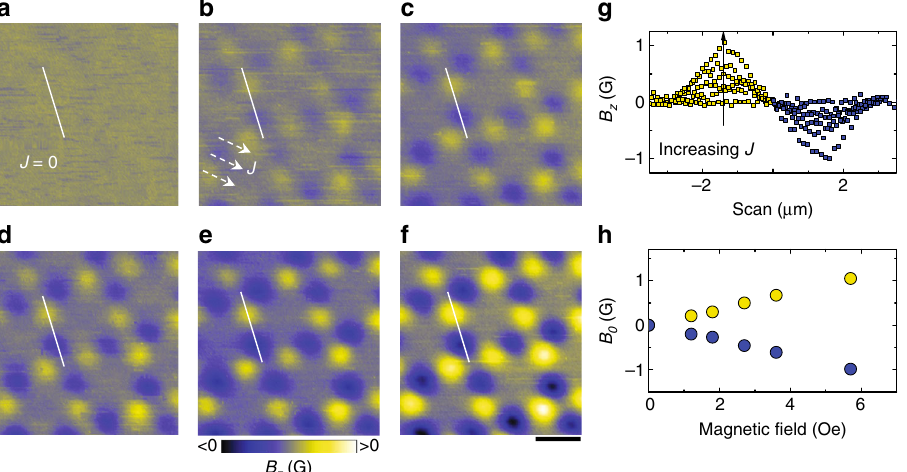
Fig. 2 Tunable strength of magnetic poles for the magnetic-charge-ice-like patterns. a – f SHPM images observed after fi rst performing zero- fi eld cooling to 4.2 K ( a ) and then increasing magnetic fi eld to 1.2 Oe ( b ), 1.8 Oe ( c ), 2.7 Oe ( d ), 3.6 Oe ( e ), 5.7 Oe ( f ). The arrows indicate the fl owing direction of the Meissner current. Scale bar, 4 μ m. g Magnetic fi eld pro fi les along the solid line shown in a – f . h The magnetic fi eld B 0 at the center of the positive and negative poles, as derived from g , exhibits a linear dependence with external magnetic fi eld (current